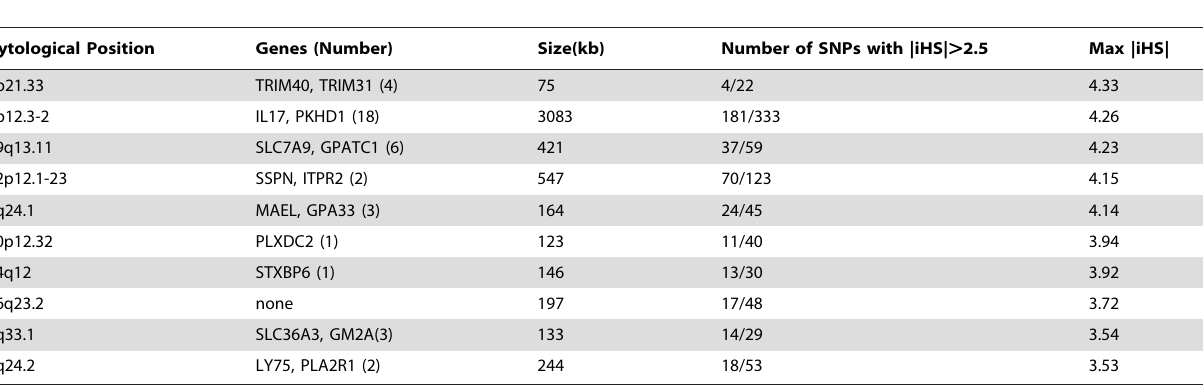
Table 2. Regions showing strongest evidence of recent positive selection in the Indigenous American component.